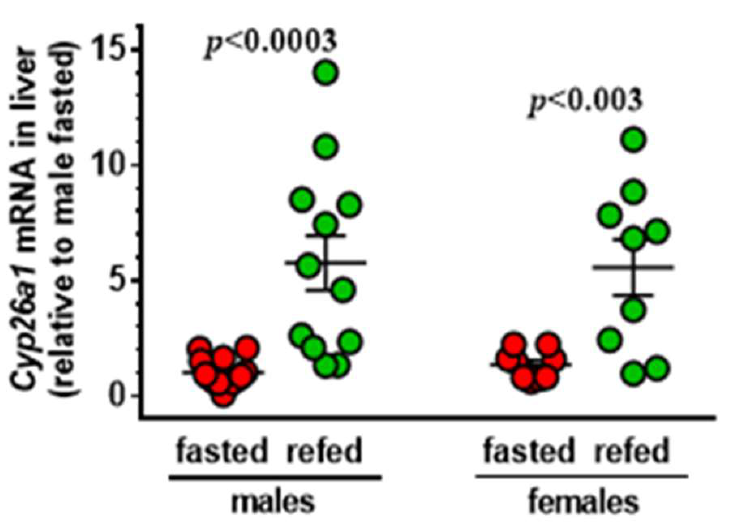
Figure 7 . Regulation of Cyp26a1 mRNA in mouse liver by fasting and re-feeding . Mice were fasted 16 h or re-fed 6 h after fasting for 16 h. Note the data spread in the refed mice. Using only 3 to 4 mice would underpower the data and could cluster data points toward one or the other